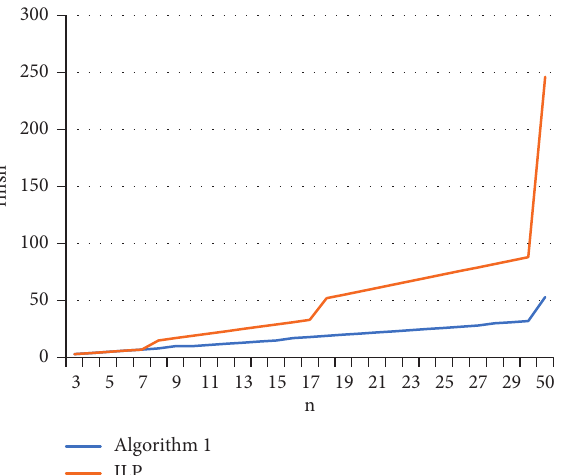
Figure 4: Comparison between standard radio mean square number, algorithm, and integer linear programming for the upper bound of radio mean square number for the cycle graph.